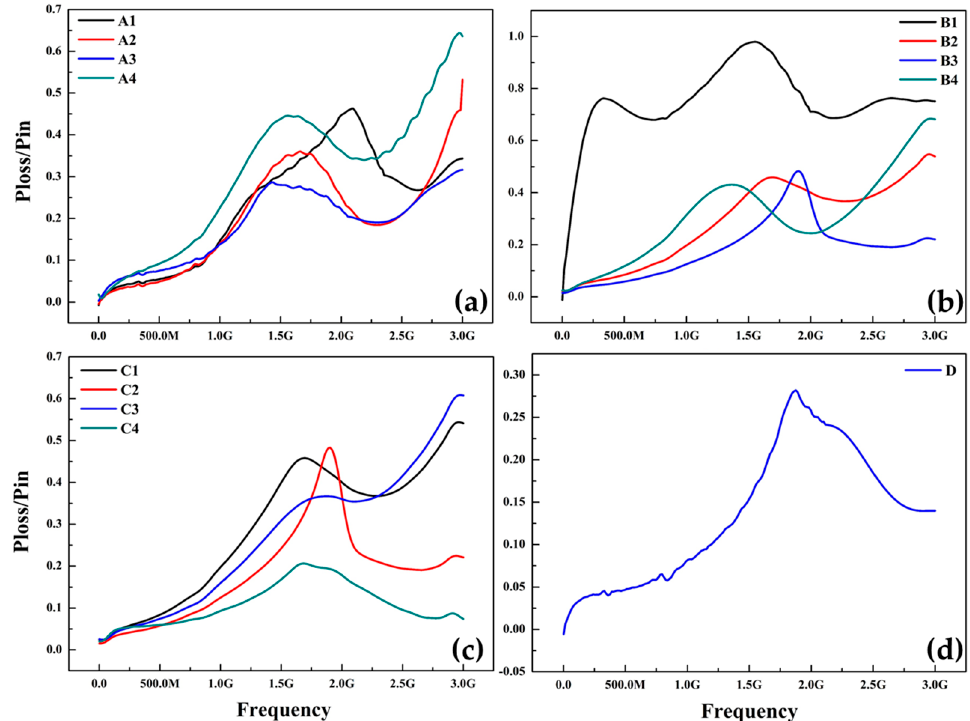
Figure 15. Power absorption (P loss /P in ) characteristics of thin films on PET substrate ( a ) Iron and Cu dopped; ( b ) FeN with varying N2 flow rates; ( c ) FeN after different deposition time spans; ( d ) FeN deposited on both sides of PET.